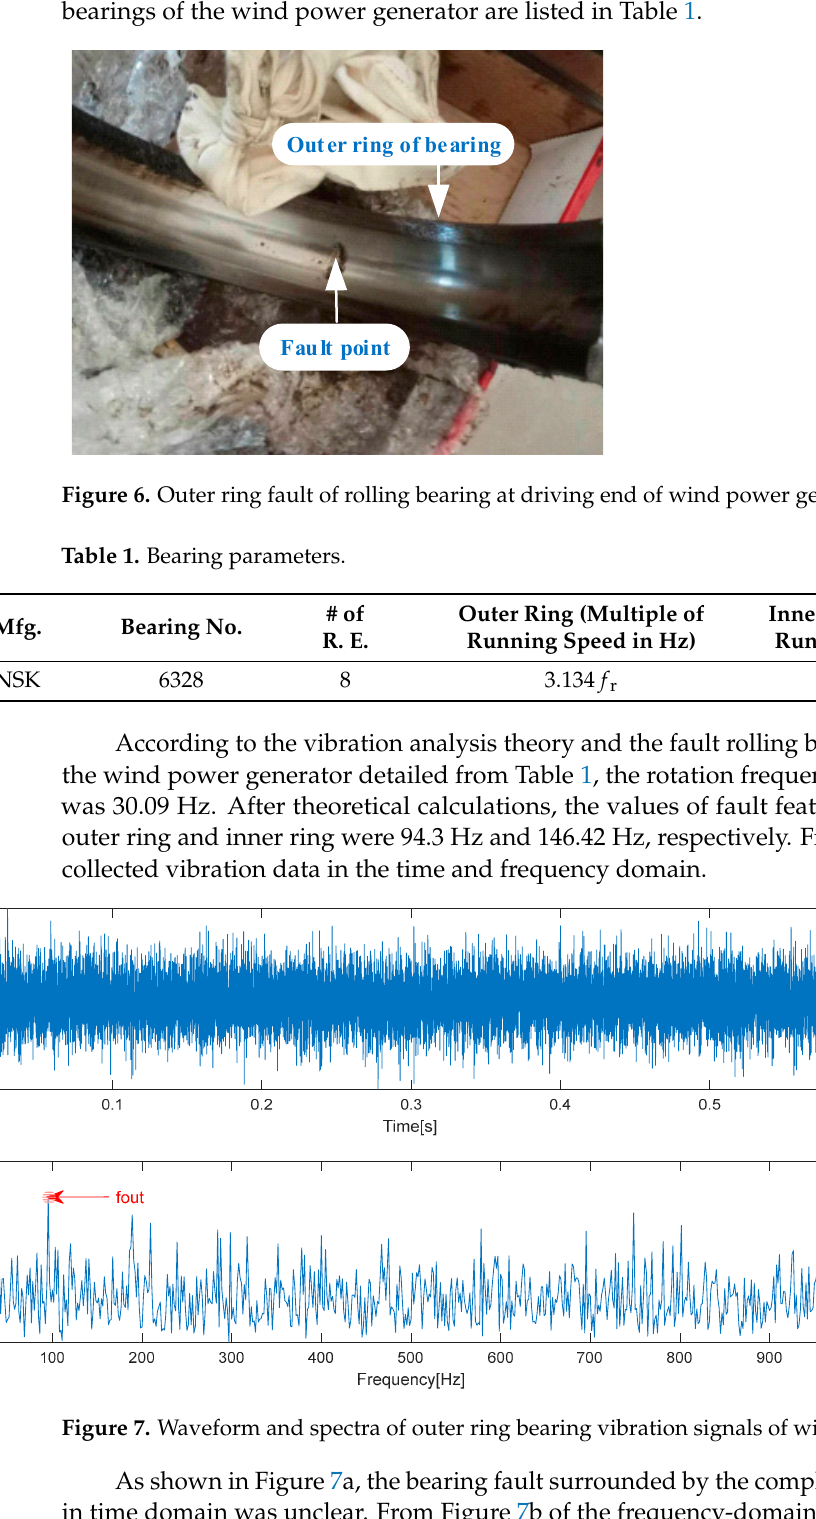
Figure 6. Outer ring fault of rolling bearing at driving end of wind power generator.